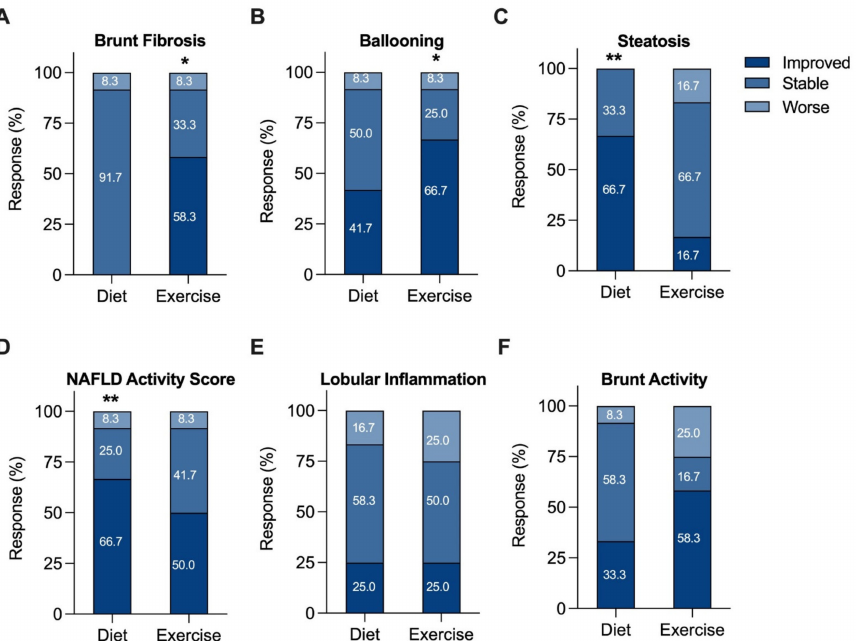
Figure 2. Changes in histologic categories (improved, stable, or worse) after a 12-week diet or exercise intervention. Any increase or decrease in score was considered a change in category. ( A ) Fibrosis, ( B ) ballooning, ( C ) steatosis, ( D ) NAFLD activity, ( E ) lobular inflammation, and ( F ) Brunt activity scores. The percent of patients in each category are shown numerically within each category of the bar graph. * p <0.05, ** p <0.01 from baseline, Wilcoxon matched pairs signed-rank